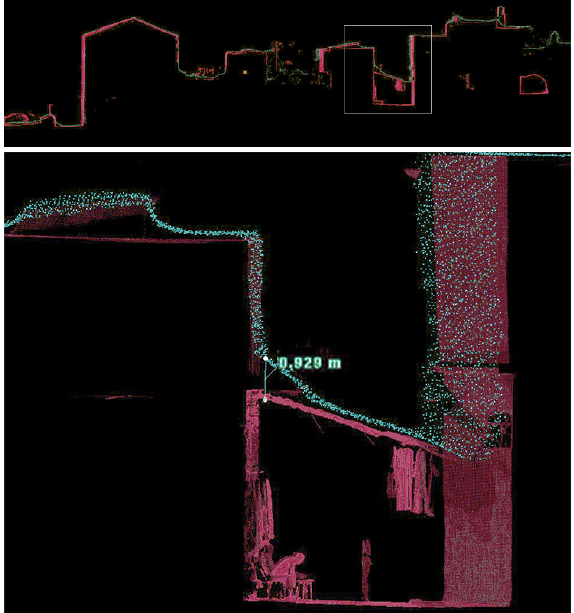
Figure 13: Overlapping of two point clouds. Reliable tests between Faro Cam 2 point cloud (red) and Phantom 4 Pro point cloud (blue).